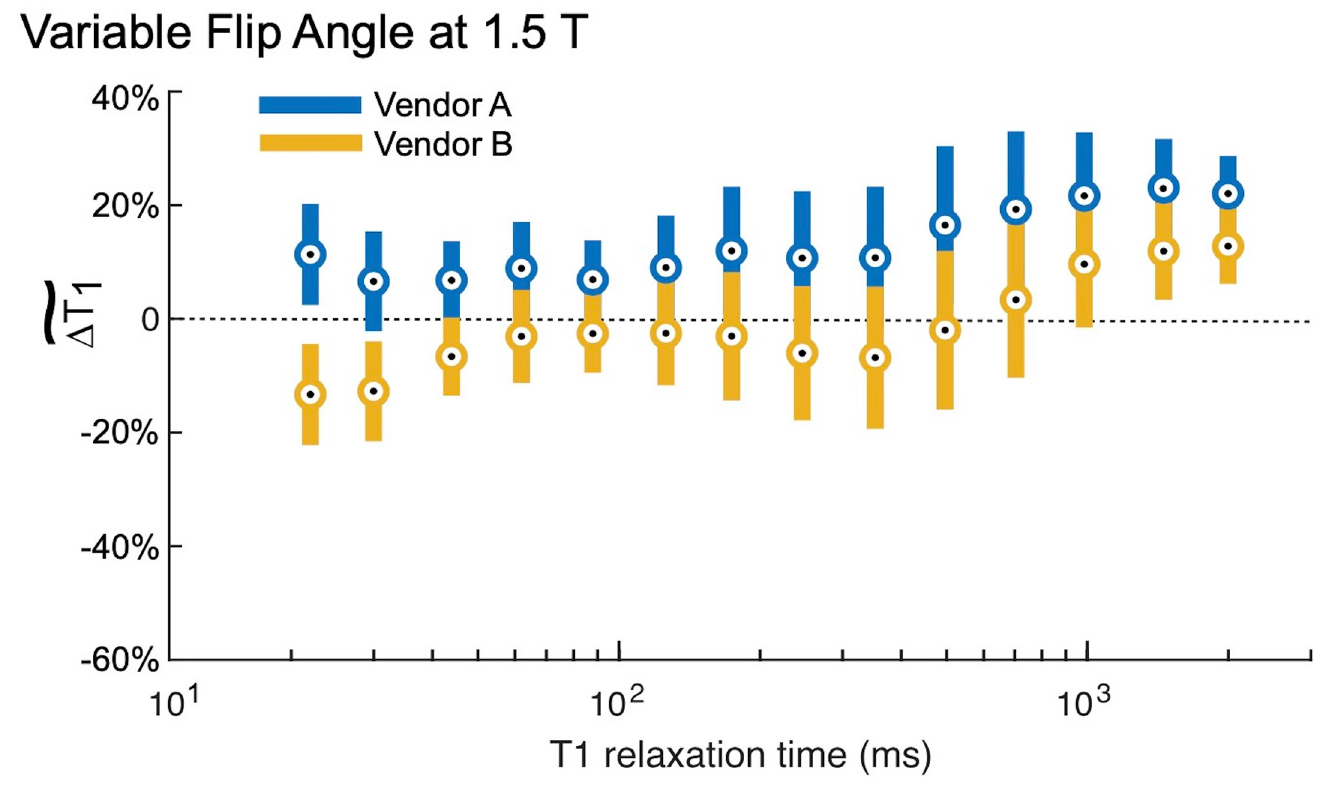
Fig 4. Variable flip angle measurements at 1.5 T. The variable flip angle (VFA) measurements at 1.5 T had a broader range of deviations than the IR measurements (Fig 2), and again both over- and underestimated the T 1,NMR . The circles represent the within group means, and the error bars are 95% confidence intervals about these means. There were significant (95% CI) differences between Vendors A & B for the two shortest T 1 relaxation times; however, the T 1 relaxation time of those spheres is below those values typically measured in the body.